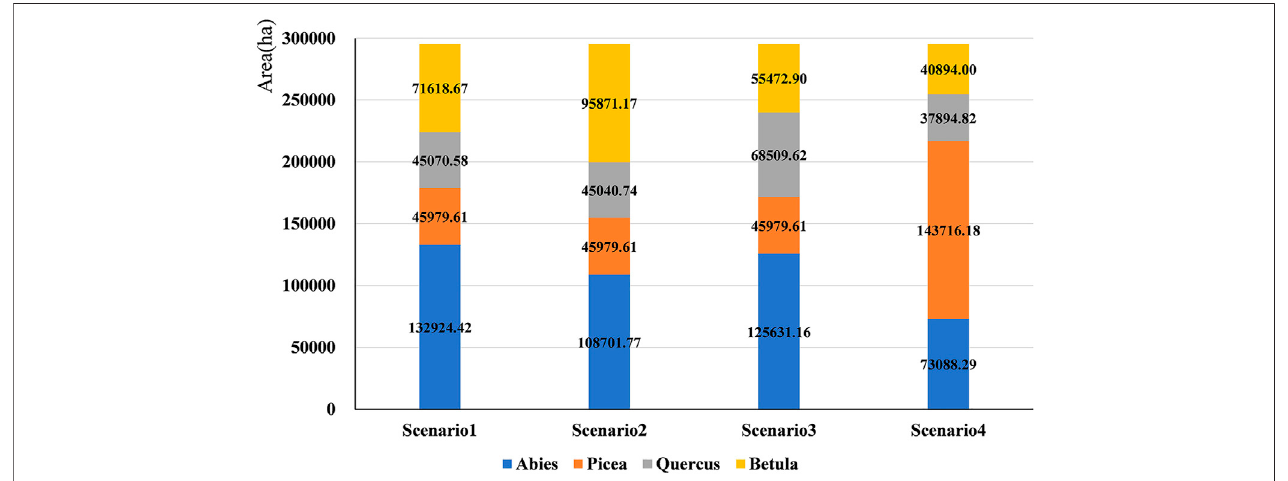
FIGURE 5 | Comparison of suitable areas of four dominant tree species under four scenarios.